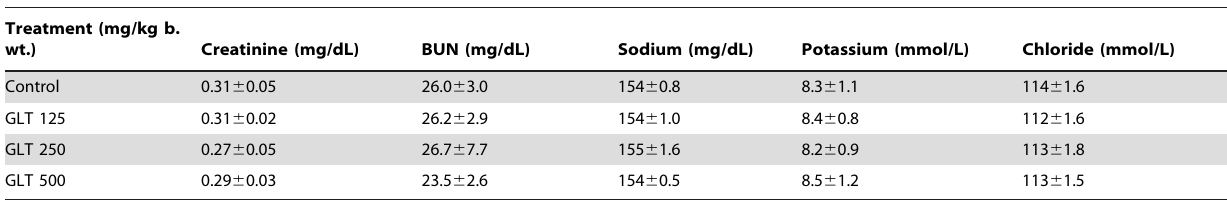
Table 3. Effect of GLT on the renal function.